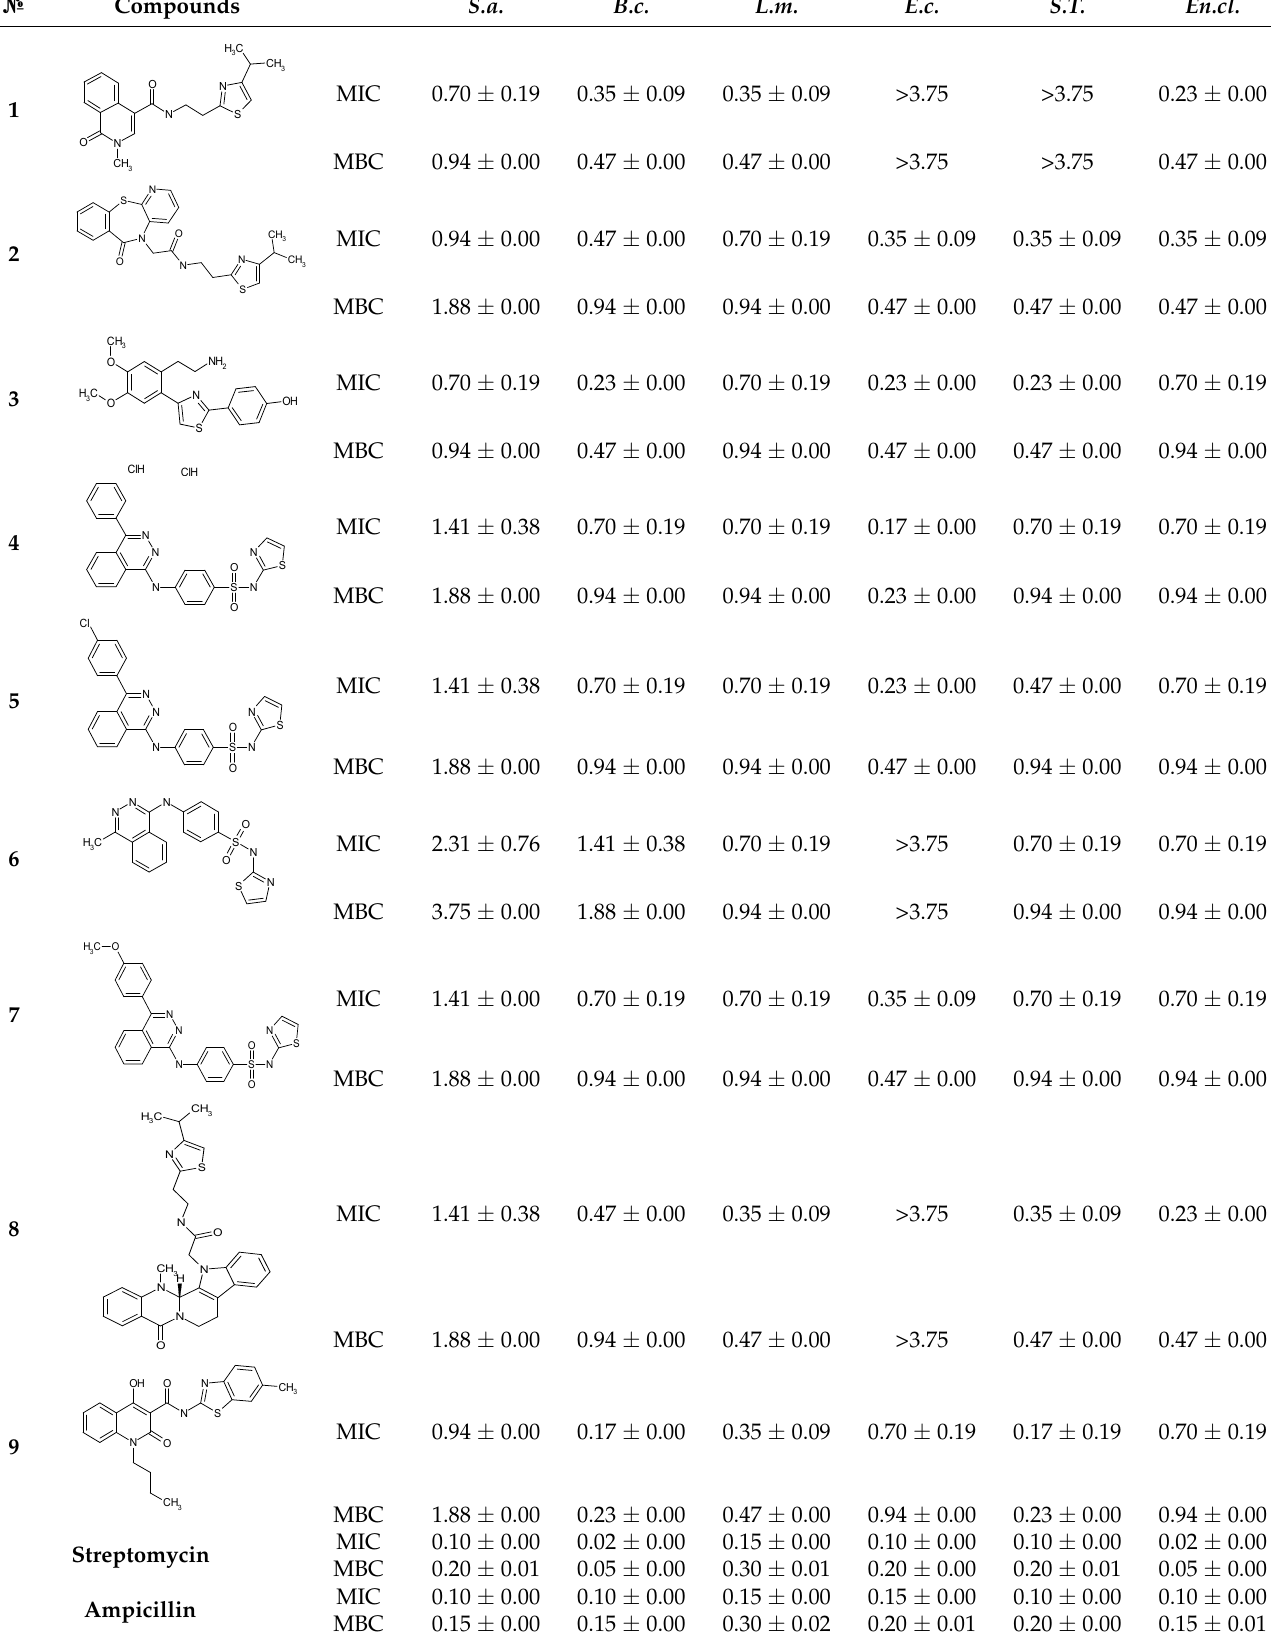
Table 1. Antibacterial activity of the title compounds (MIC/MBC in mg/mL). № Compounds